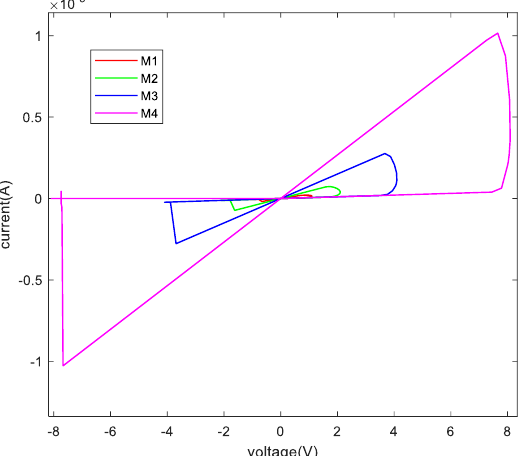
Figure 7. The relationship between voltage and current of the four